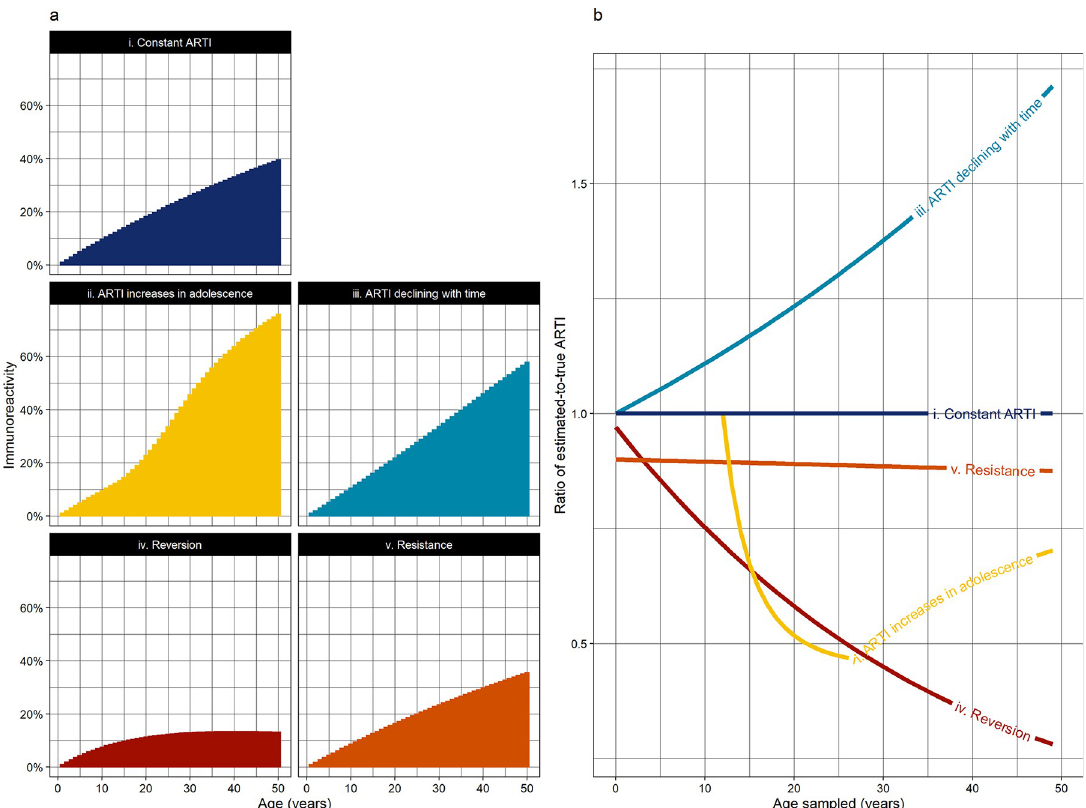
Fig 2. a. Age-dependent cross-sectional population prevalence of Mycobacterium tuberculosis (Mtb) immunoreactivity under differing epidemiological assumptions: i) Constant annual risk of tuberculosis infection (ARTI) of 1%, with no reversion, secular trends or age- related trends; ii) Childhood ARTI of 1% which increases from age 12 to a maximum of 4% in adulthood [58]; iii) Current ARTI of 1% in all age groups on a background of a secular decline in ARTI of 2% per year[4]; iv) Constant ARTI of 1%, but with 5% annual reversion [59]; v) Constant ARTI of 1%, assuming 10% of the population are resistant to infection and remain immune-nonreactive [60]. b. The degree to which age-specific ARTIs would be under- or over-estimated in each scenario, by age group sampled, if a constant rate of infection with no reversion were assumed (i.e. using ARTI = 1 − (1 − Prevalence) 1/Mean age ).